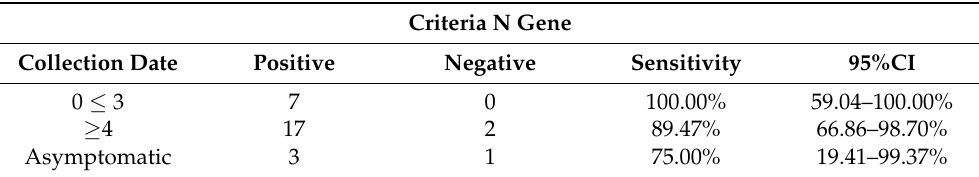
Table 3. Clinical sensitivity of the GenBody COVID-19 Ag test (COVAG025) based on sample